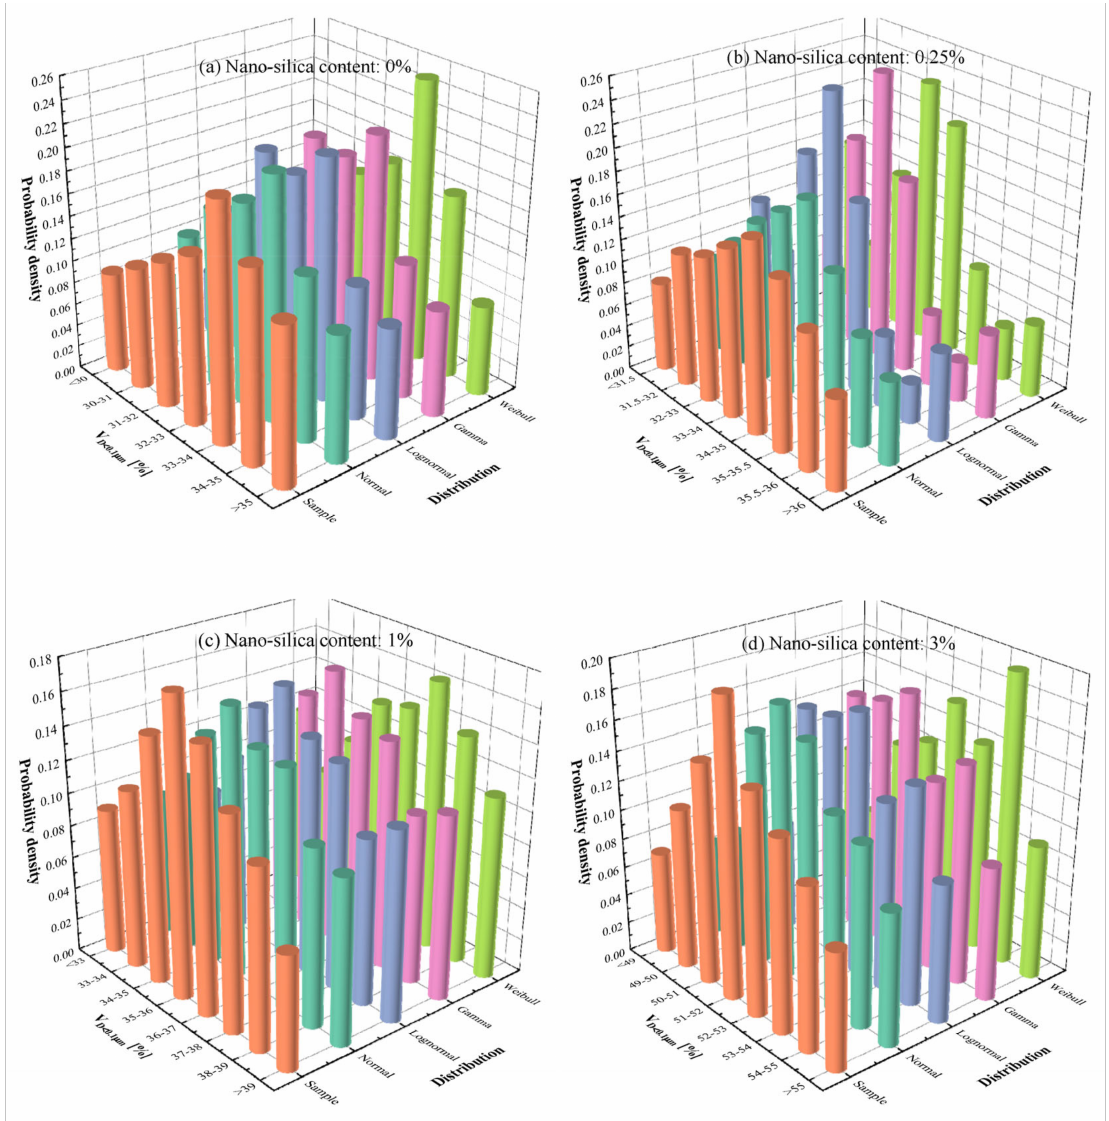
Figure 11. The distribution laws of potential probability distributions and measured V D < 0.1 µ m